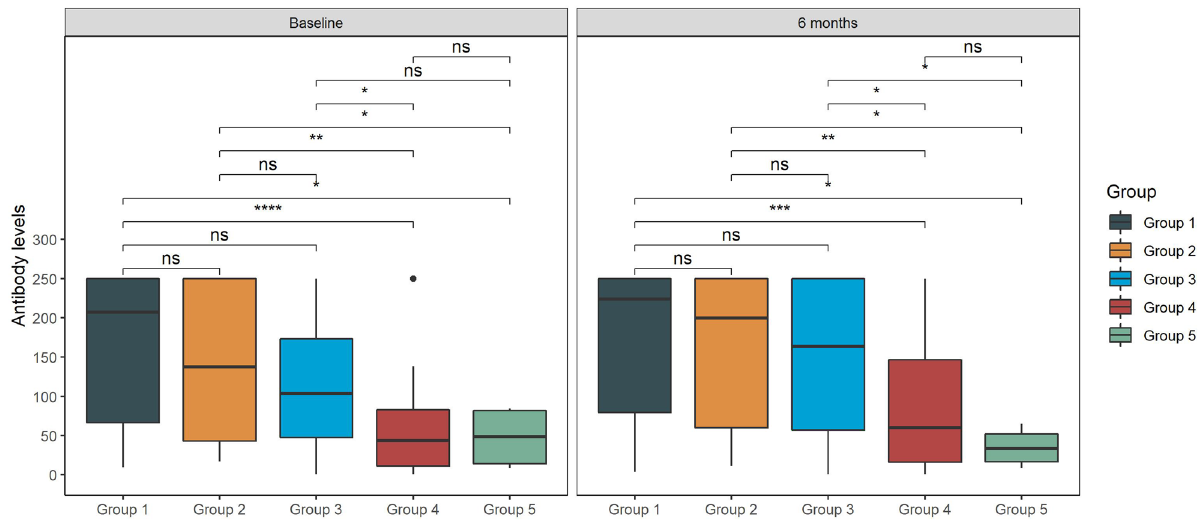
Figure 3. Quantitative test distribution per group stratified according to baseline and 6-month follow up data. Values are expressed in